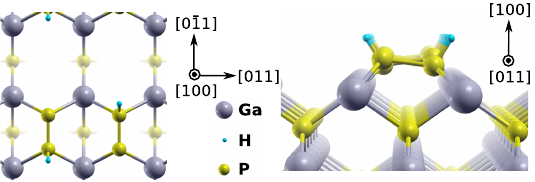
Figure 1: The P-rich, p ( 2 × 2 ) / c ( 4 × 2 ) 2P–1H surface reconstruction of GaP(100) in a ball-and-stick